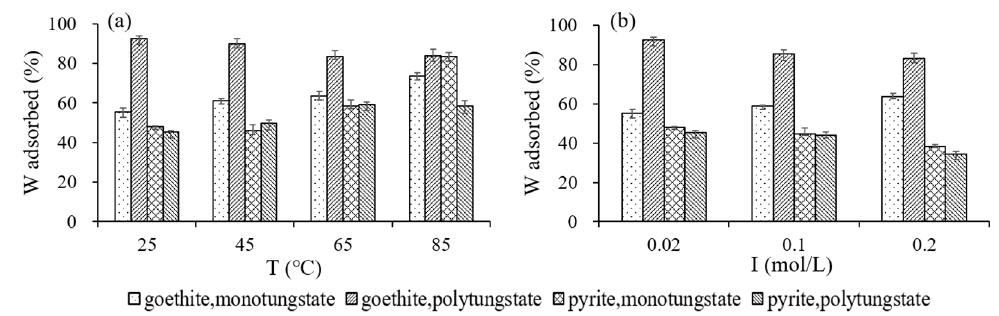
Figure 6. Effects of temperature ( a ) and ionic strength ( b ) on the adsorption of tungsten by pyrite and goethite. T: temperature; I: ironic strength; W: tungsten.